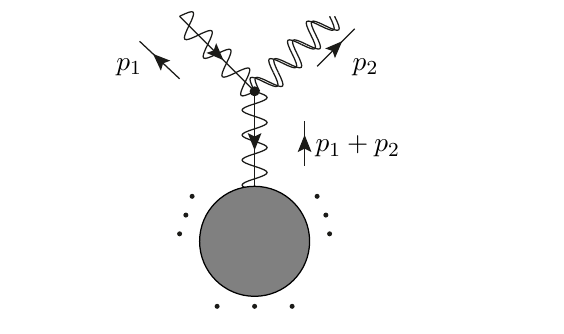
Figure 19 . Feynman diagrams leading to collinear gravitino and graviton